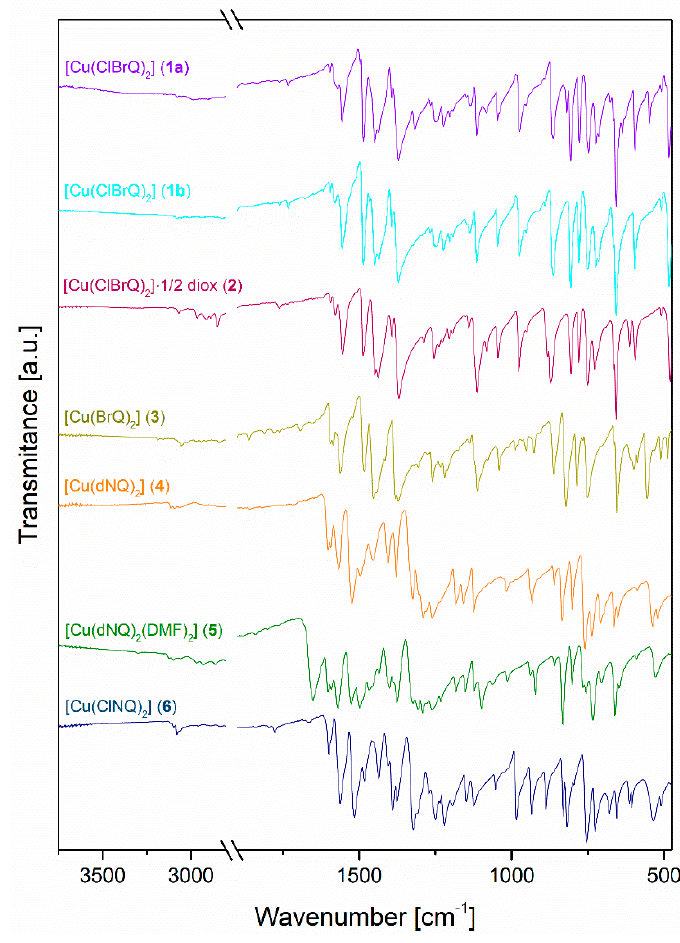
Figure 1. FT–IR spectra of 1 – 6 .